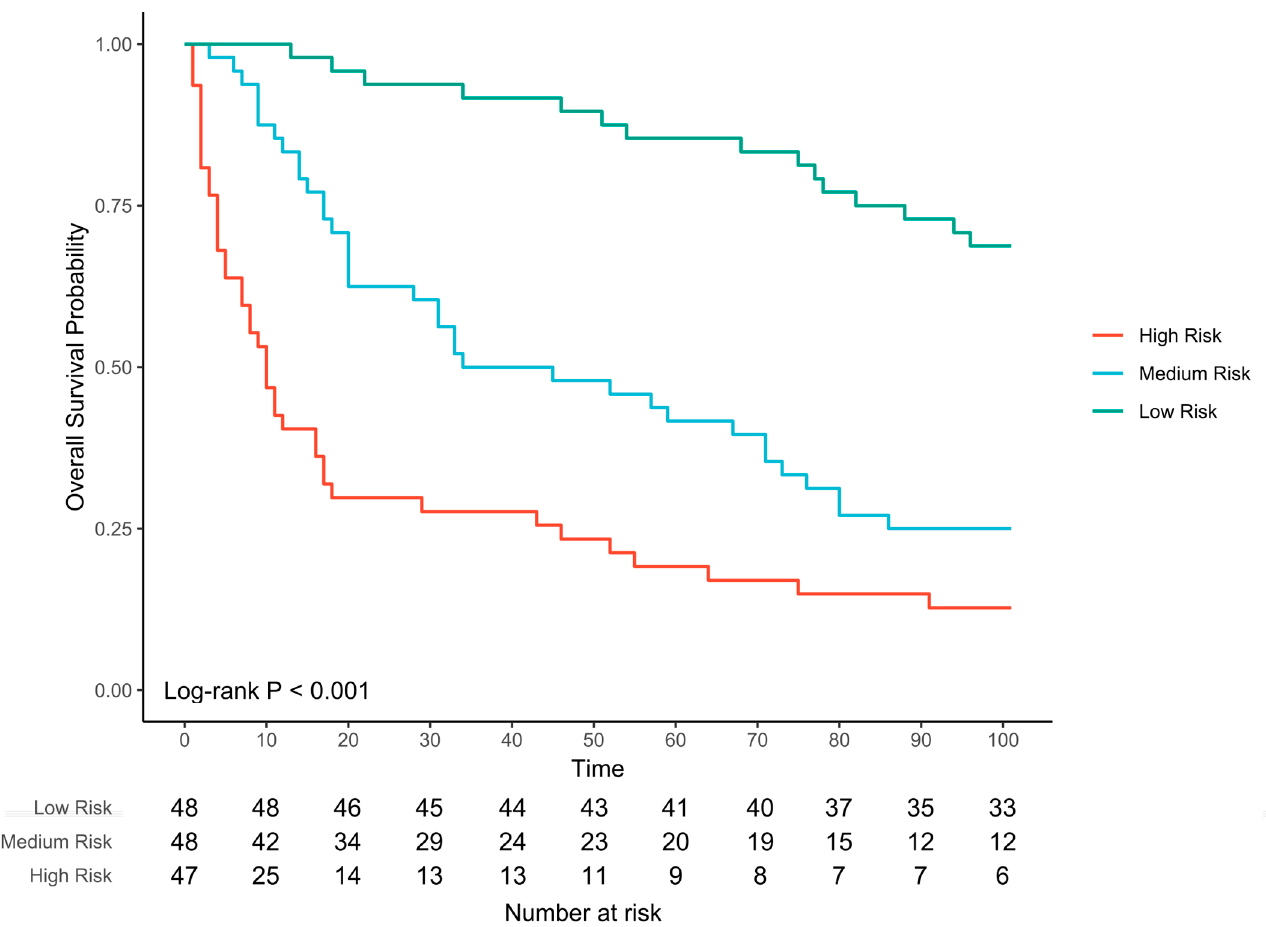
Figure 3. Kaplan–Meier survival curves using the Cox Lasso regression model. It shows three groupings based on prediction of 21-day risk, representing high, medium and low risk of